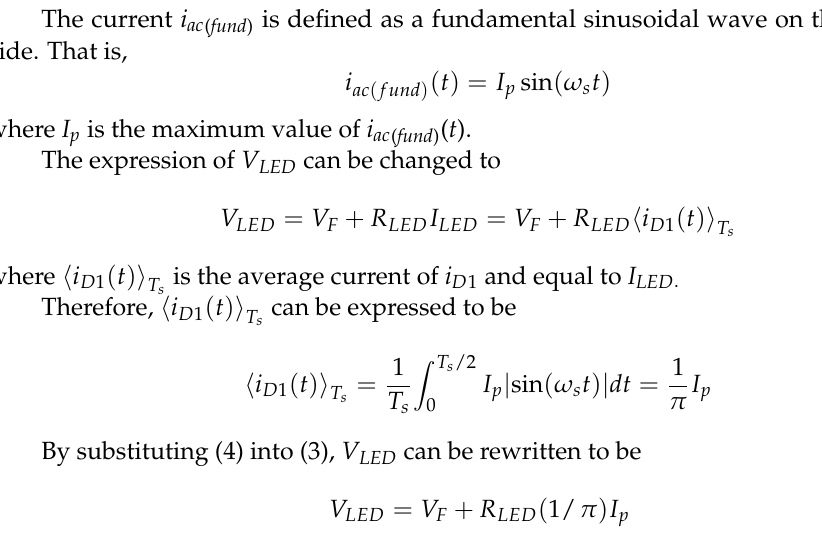
Figure 6. AC equivalent circuit of the proposed LED driver.